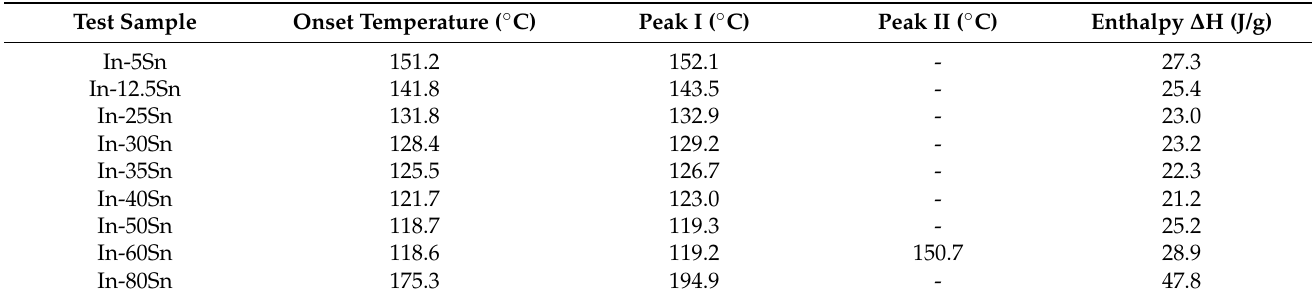
Table 1. Thermal properties of In-Sn solder alloys during heating.